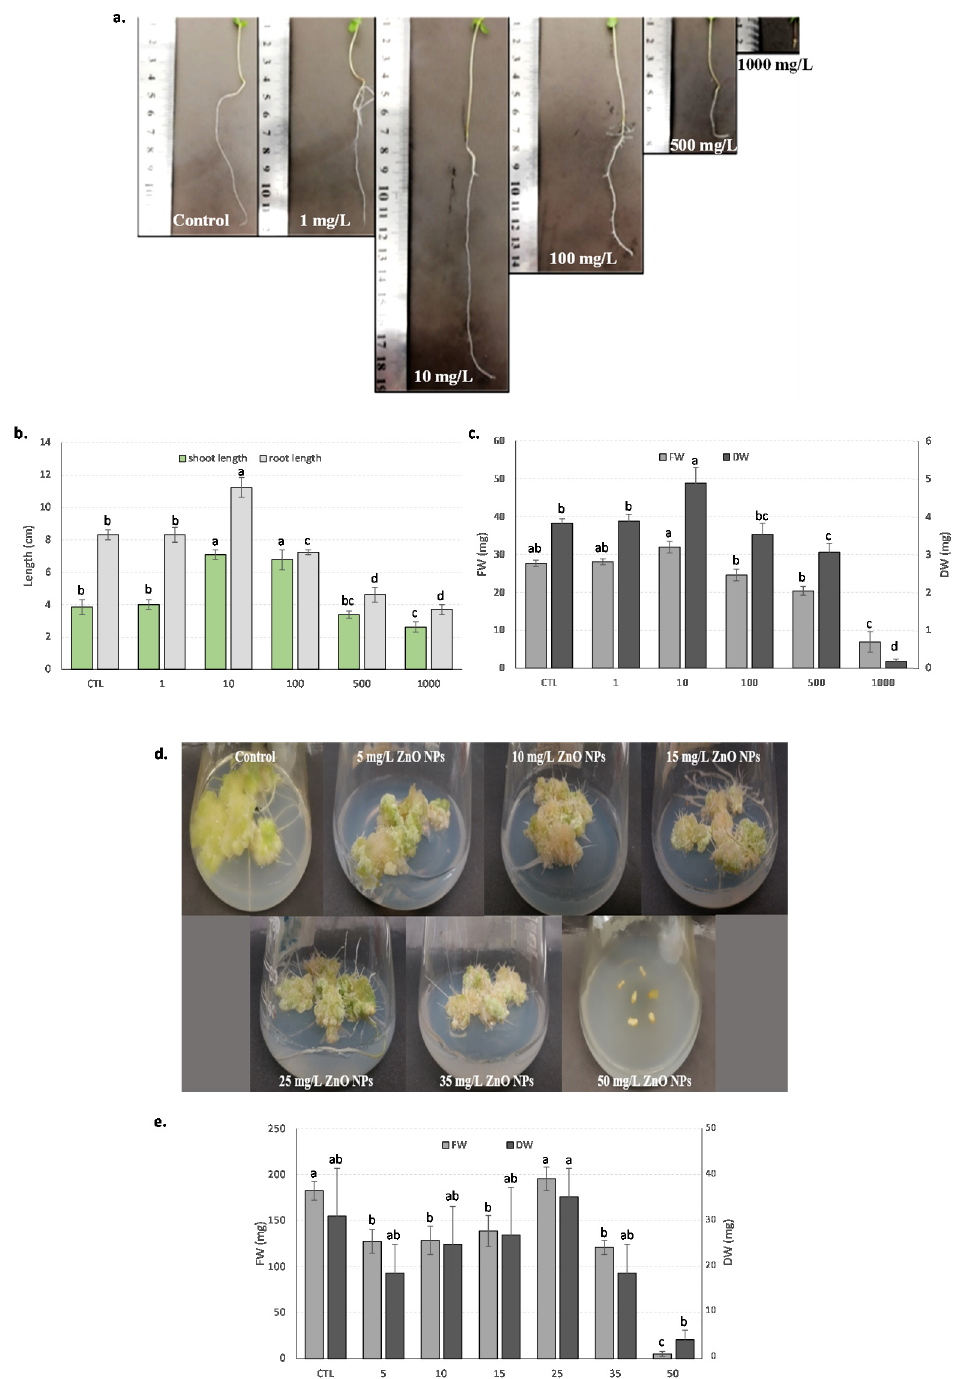
Figure 1. Effect of zinc oxide nanoparticles (ZnONPs) on the seedlings and the stem-derived callus of L. usitatissimum . ( a ) The morphological evaluation with the centimeter scale to comprehend the root and shoot length of the L. usitatissimum seedlings at different concentrations of ZnONPs; ( b ) the trends in the root and shoot length of the L. usitatissimum seedlings at different concentrations of ZnONPs (the x axis represents the control (CTL) and the ZnONP treatment (at 1, 10, 100, 500 and 1000 mg / L ZnONPs, respectively) conditions); ( c ) the biomass (fresh and dry weight) accumulation of L. usitatissimum seedlings at different concentrations of ZnONPs (the x axis represents the control (CTL) and the ZnONP treatment at 1, 10, 100, 500 and 1000 mg / L ZnONPs, respectively) conditions); ( d ) the morphological evaluation (of